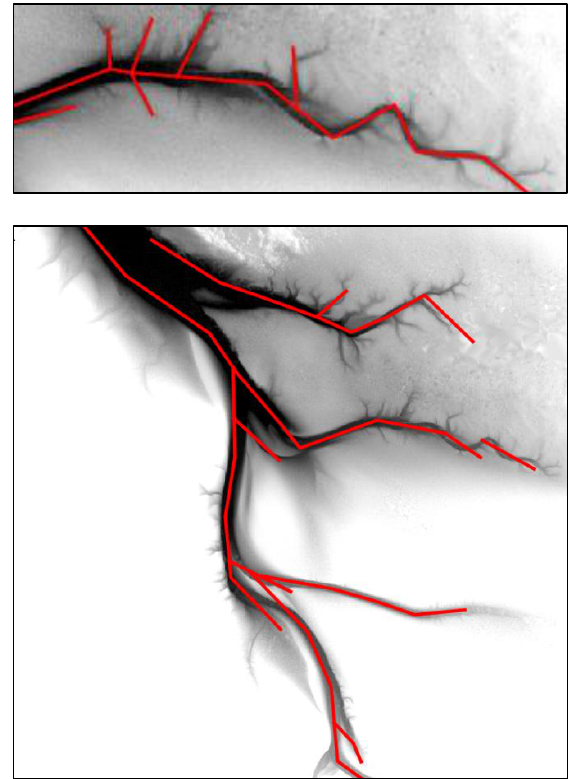
Figure 10. Constructed network graph for area 1 ( c i = 200, l i max = 7, iterations = 35 million) and the whole test site ( c i = 250, l i max = 5, iterations = 17.4